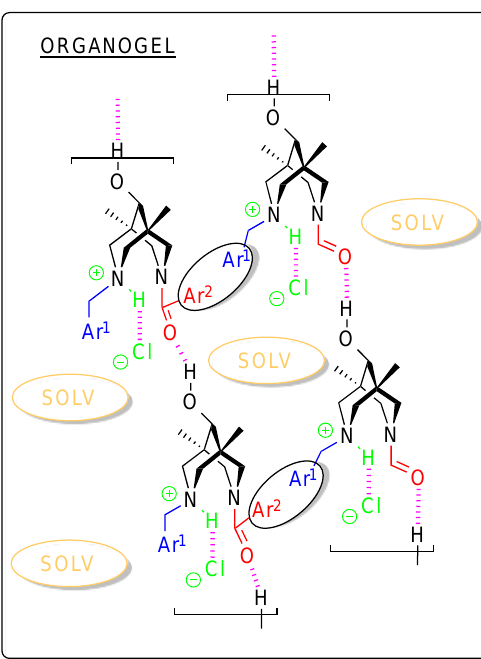
Figure S1: Photo of 4ae*HCl in nitrobenzene, Figure S2: Photo of 4ae*HCl in ethoxybenzene, Figure S3: Photo of 4ae*HCl in mesitylene, Figure S4: Photo of 4ab*HCl in nitrobenzene, Figure S5: Photo of 4ab*HCl S8: Dependence of viscosity on shear rate, Figure S9: Dependence of the loss and accumulation modules on angular frequency, Figure S10: Molecular structure of 4cb , Figure S11: Molecular structure of 2c , Figure S12: Molecular structure of 3a , Figure S13: Molecular structure of 3c , Figure S14: Molecular structure of 4da*HCl*(C 6 H 6 ) 2 , Figure S15: Hydrogen-bonded finite motif in the structure 1c+H2O , Figure S16: Molecular structure of 5,7-dimethyl-1,3-diazaadamantan-6-one, Figure S17: The structures a) and b) of ketone and its diol form in the crystal 1c, Figure S18: Scatterplot of C9 …N separations in structures of neutral organic flexible bispidines, Figure S19: Histogram of absolute differences between C9…N separations , Figure S20: TEM micrograph of